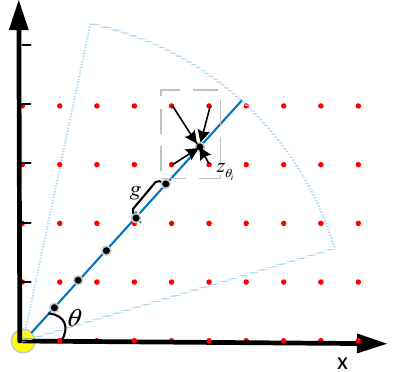
Figure 4. Estimation of the elevation value of the node in any sensing direction.